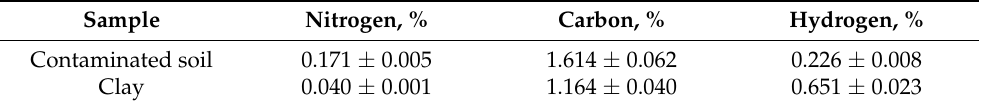
Table 4. Elemental analysis test of the contaminated soil and clay.